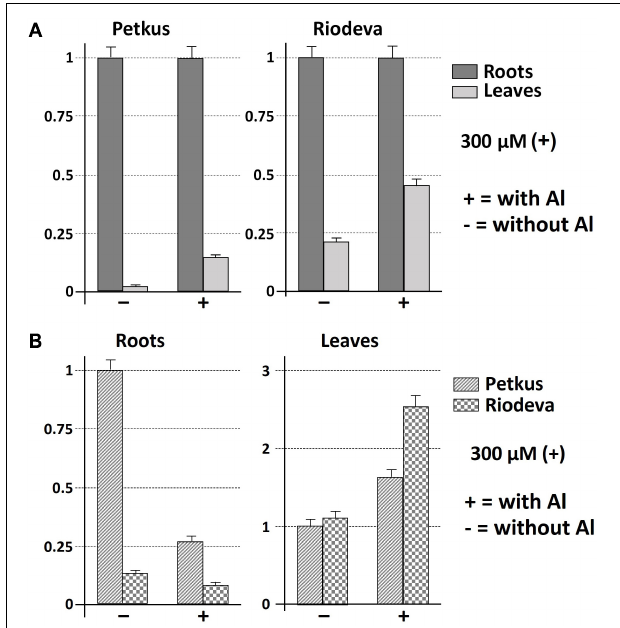
FIGURE 3 | Expression patterns (qRT-PCR) of ScCS4 under 300 µ M AlK (SO4) 2 at 24 h of treatment with AlK (SO4) 2 (+) and without AlK (SO4) 2 ( − ) using root apices and leafs of Riodeva (sensitive inbred line) and Petkus (tolerant cultivar). The expression level of 18S rRNA was used as a loading control. Error bars represent standard deviations (SDs). All data are the means of three independent biological and technical replicates. (A) ScCS4 expression level of leaves compared with roots in Petkus and Riodeva. The relative expression level 1 for Petkus roots with and without aluminum and the relative expression level 1 for Riodeva roots with and without aluminum do not mean that there is the same amount of citrate synthase messenger RNA in the different situations. In all four cases, the roots have been selected as a reference. (B) ScCS4 expression level of Riodeva compared with Petkus in roots and leaves. Change at each time point is expressed as the relative difference in expression compared with roots of the Petkus without Al or with leaves of the Petkus without Al. Y-axis: change (fold difference) at each time point is expressed as the relative difference in expression compared with the case selected as reference (relative expression level